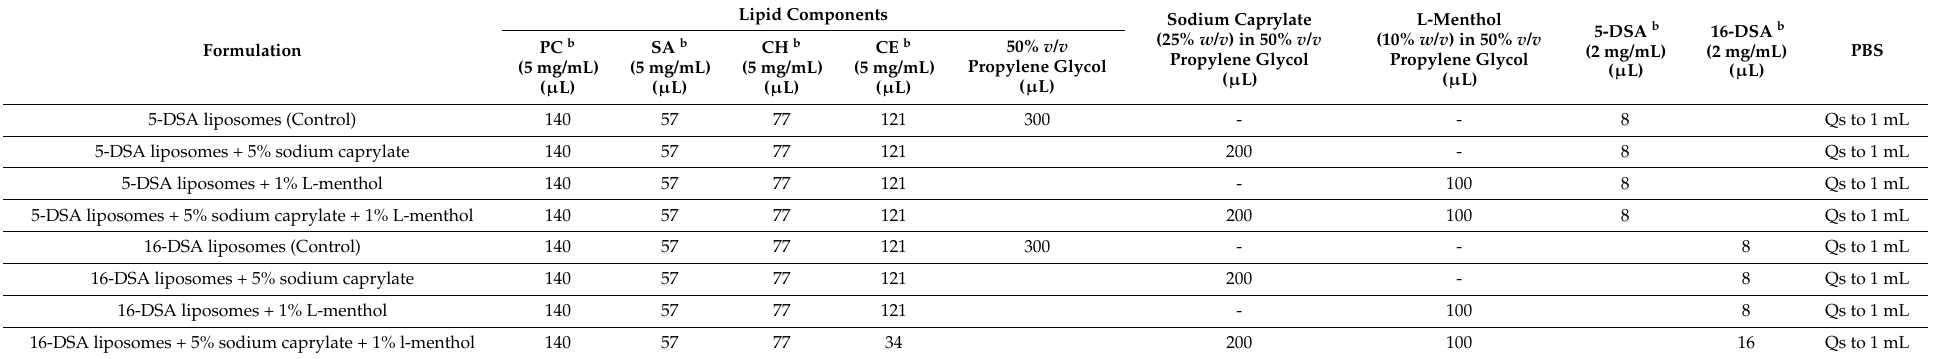
Table 3. Composition of buccal prototype liposomes a